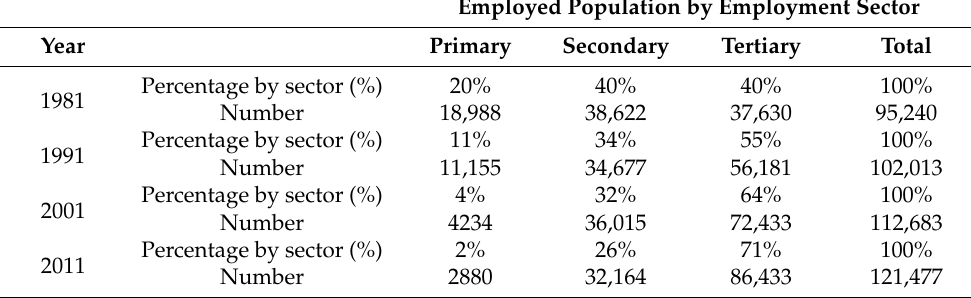
Table 4. Distribution of residents by sector of